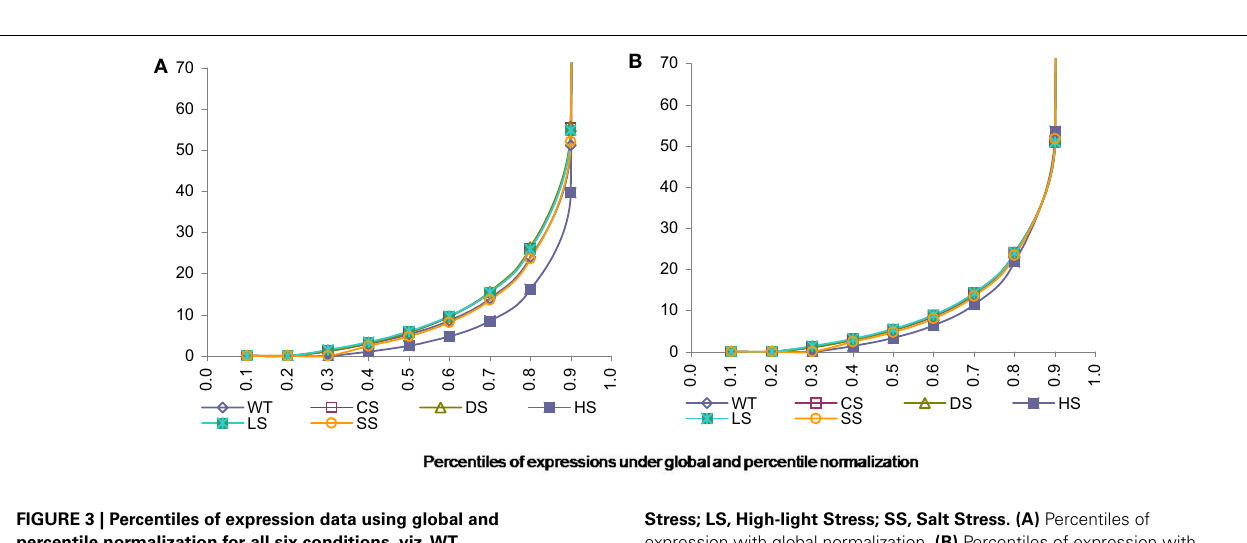
FIGURE 2 | Percentile distributions for first, second, second last, and last exons from transcription start site for single isoform genes. Note that all the figures have been zoom-in for better visibility thus last percentiles have